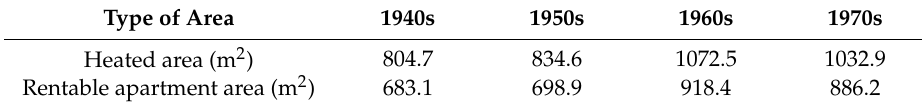
Table 5. Heated area and rentable apartment are in the studied building types.